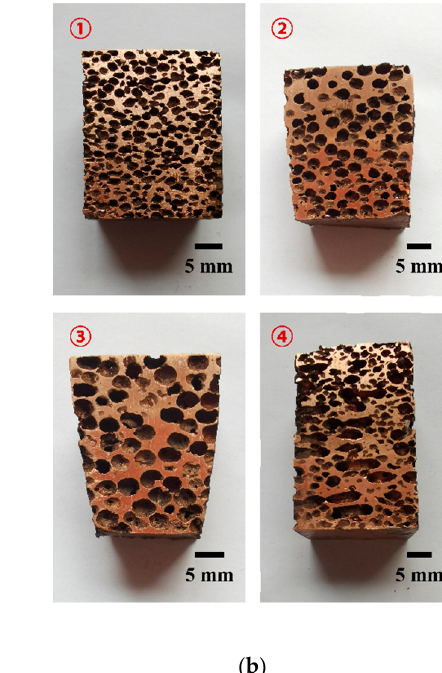
Figure 5. The resulting metal foam: ( a ) the aluminium foam ( ① , ② , and ③ have a spherical cell structure, and the size of the cells are Φ 2, Φ 3, and Φ 4 mm, respectively, while ④ has a composite cells structure, composed of Φ 2 and a hexagonal mesh structure), and ( b ) the copper foam (which is the same as the aluminium foam). Table 1. The ratio of the components.